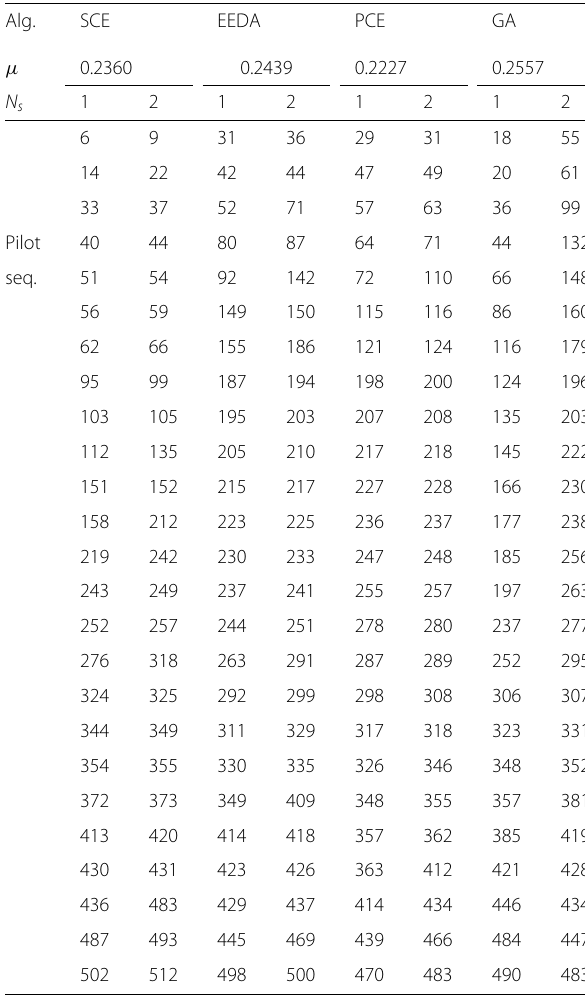
Table 1 Sample pilot sequences and their mutual